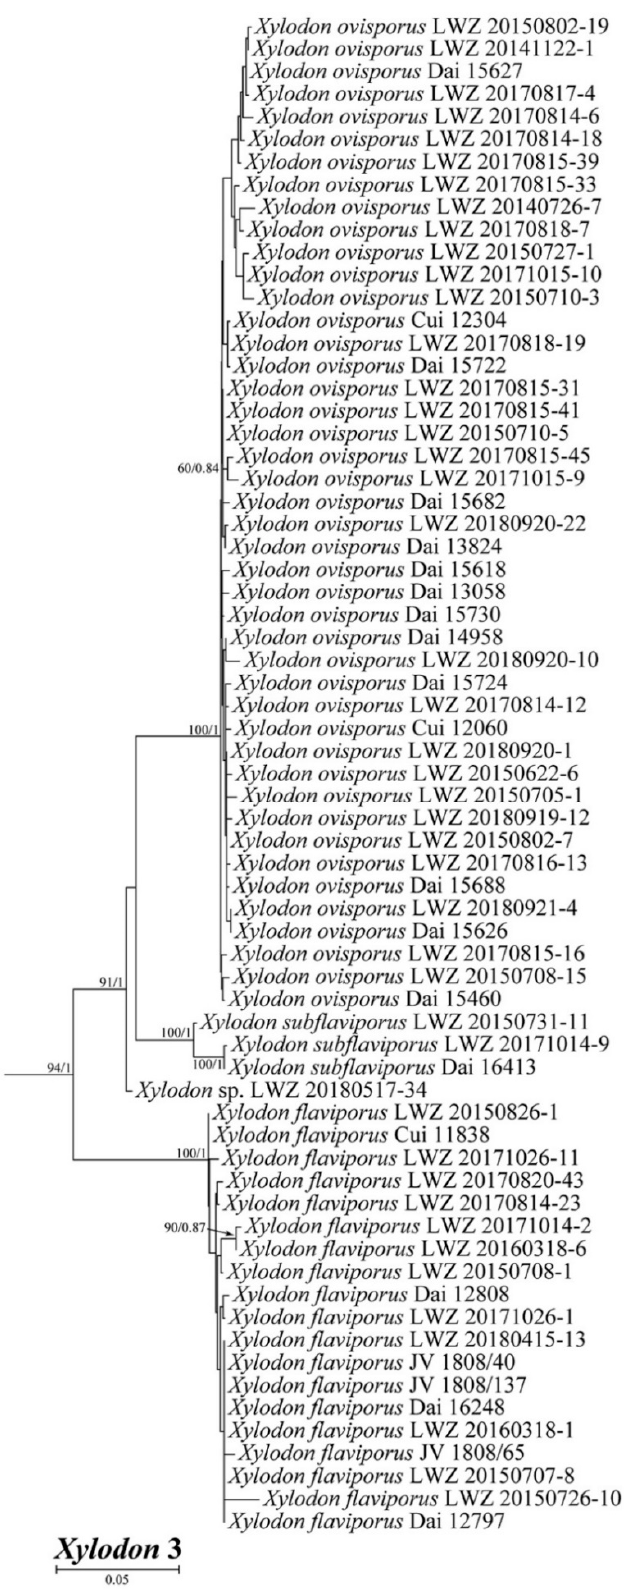
Figure 5. Phylogenetic relationship among species of Xylodon inferred from the combined dataset of ITS, nLSU, mt-SSU, tef1 α , rpb1 , rpb2 and atp6 regions. The topology generated by the maximum likelihood algorithm is presented along with the bootstrap values and the Bayesian posterior probabilities above 50% and 0.8, respectively, at the nodes.